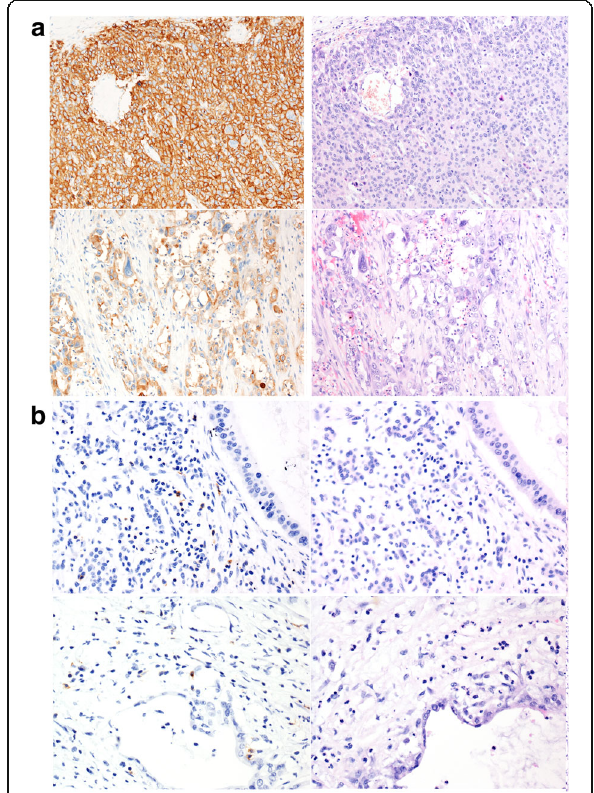
Fig. 1 Exemplary figures for PD-L1 and PD-1 staining with corresponding H&E staining. a PD-L1 staining in PDAC tissue. PD-L1 staining was primarily observed on tumor cell membranes. Magnification, 10× objective. b PD-1 staining in PDAC tissue. PD-1 staining was primarily observed in tumor-infiltrating lymphocytes in the tissue. Magnification, 10× objective. Scale bars are equivalent to 100 μ